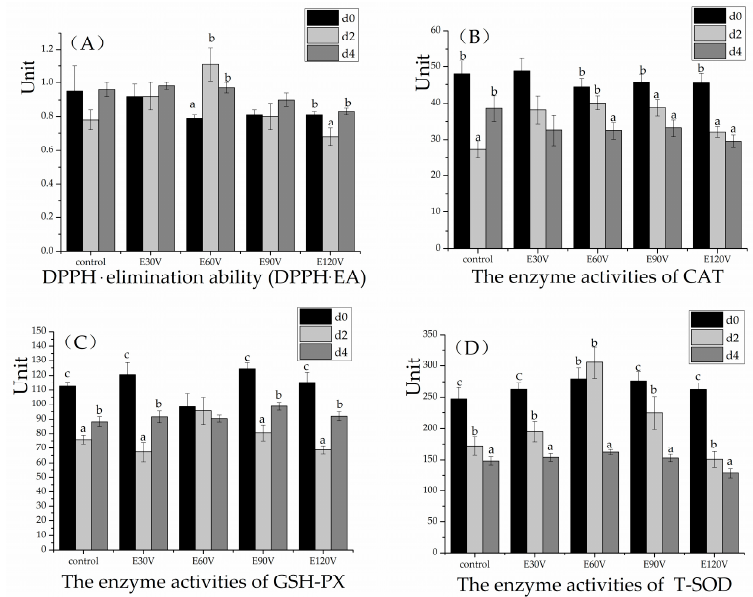
Figure 2. The e ff ect of storage (4 ◦ C) times on antioxidant capacity stability in meat goose livers Figure 2. The effect of storage (4 °C) times on antioxidant capacity stability in meat goose livers with different electrical stunning (ES) methods. Figures A, B, C, D respectively represents the effect of ES on 1,1-diphenyl-2-picrylhydrazyl free radical (DPPH·) elimination ability (DPPH·EA), activities of catalase (CAT), glutathione peroxidase (GSH-PX), and total superoxide dismutase (T-SOD) in livers.